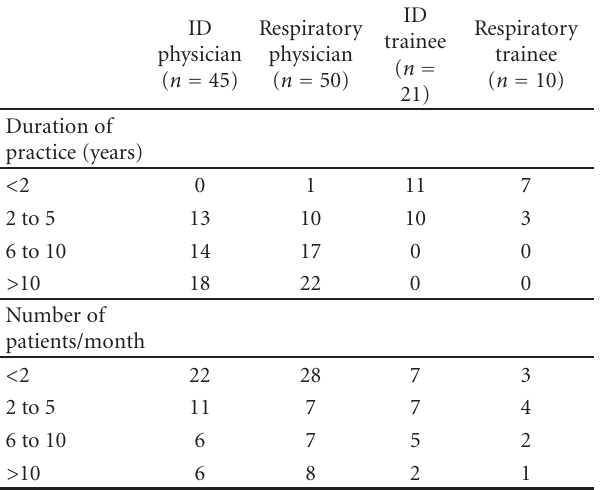
Table 1: Participants